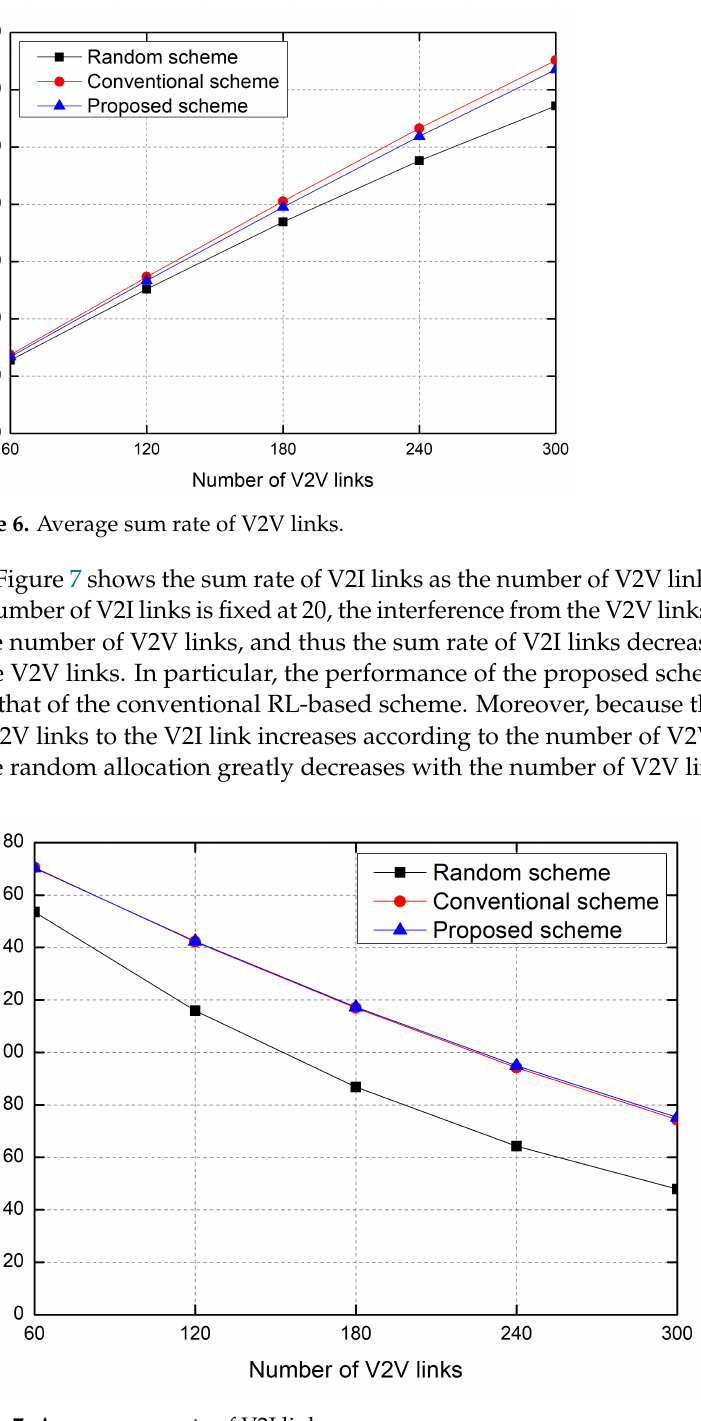
Figure 7. Average sum rate of V2I